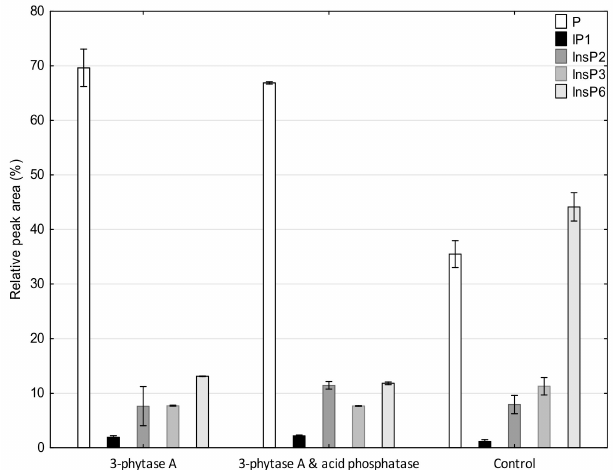
Figure 1. Profile of the inositol phosphates by HPAEC–UV / Vis chromatography on CarboPackPA1 column obtained from the analysis of the buckwheat wort using the mashing program optimized for the activity of phytases.